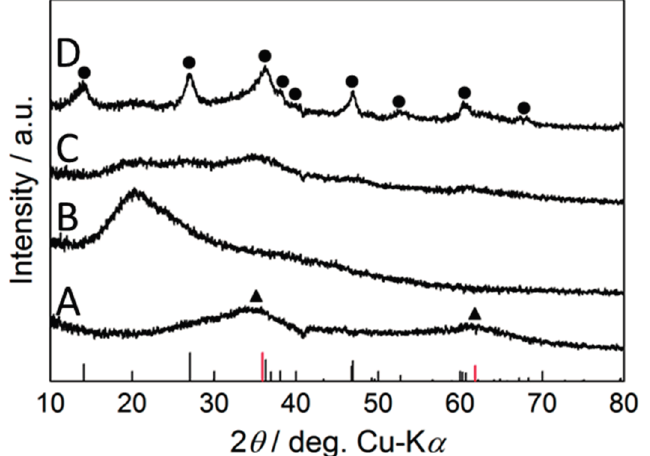
Figure 4. XRD patterns of cultured sheaths in SGP containing different Fe sources: ( A ) three Fe plates or 150 μ m Fe powder at ( B ) 0.14 g/L, ( C ) 1.4 g/L, ( D ) 14 g/L. The main diffraction peaks for lepidocrocite (black circles) were assigned using ICDD database of lepidocrocite (PDF 00-044-1415). The position of the diffraction peaks for 2Fh (black triangle) was assigned using the data of 2Fh [29] and is given as black and red bars at the bottom of the figure, respectively. The break near 40° corresponds to the peaks derived from the sample